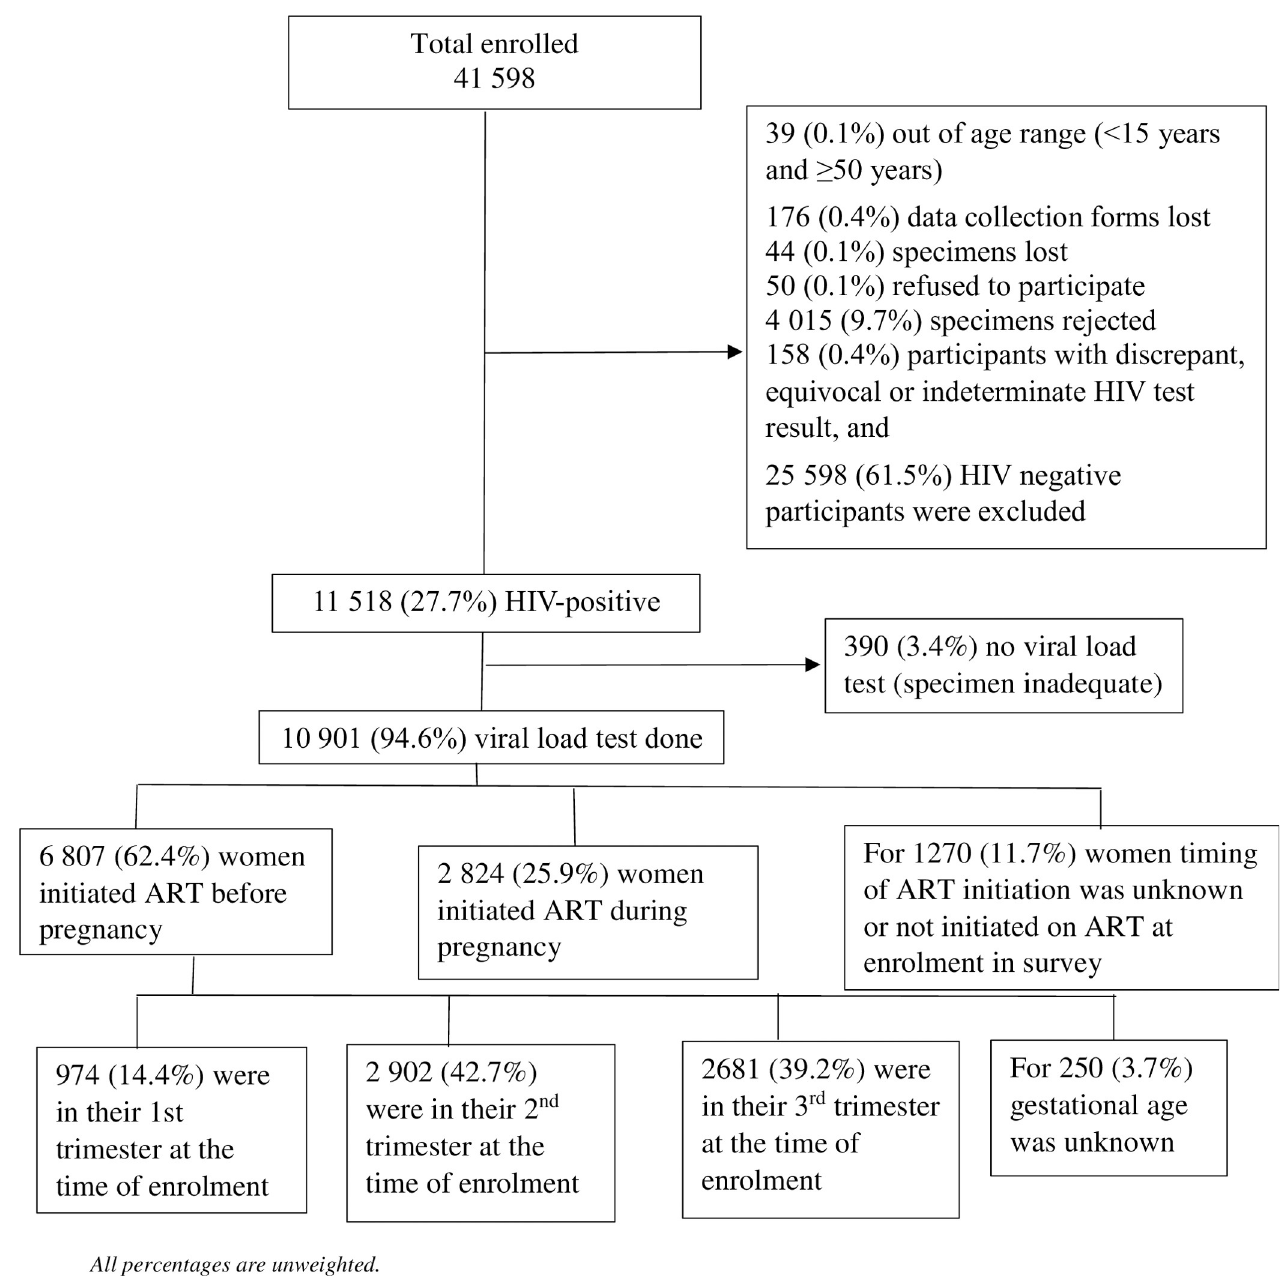
Fig 1. Flow chart of observations excluded from the analysis, the 2019 antenatal HIV Sentinel Survey, South Africa.